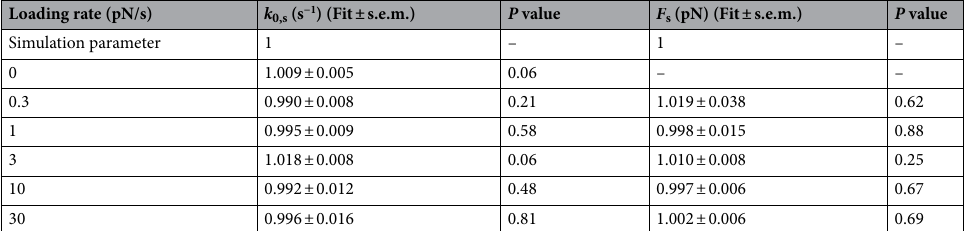
Table 1. Mean fit parameters from simulated slip bond dissociation data sets. Reported values represent the mean ± s.e.m. of the fit parameters for 50 sets of N = 1000 simulated slip bond dissociations under the increasing load rate, as indicated. In all cases, P values are calculated for two-tailed